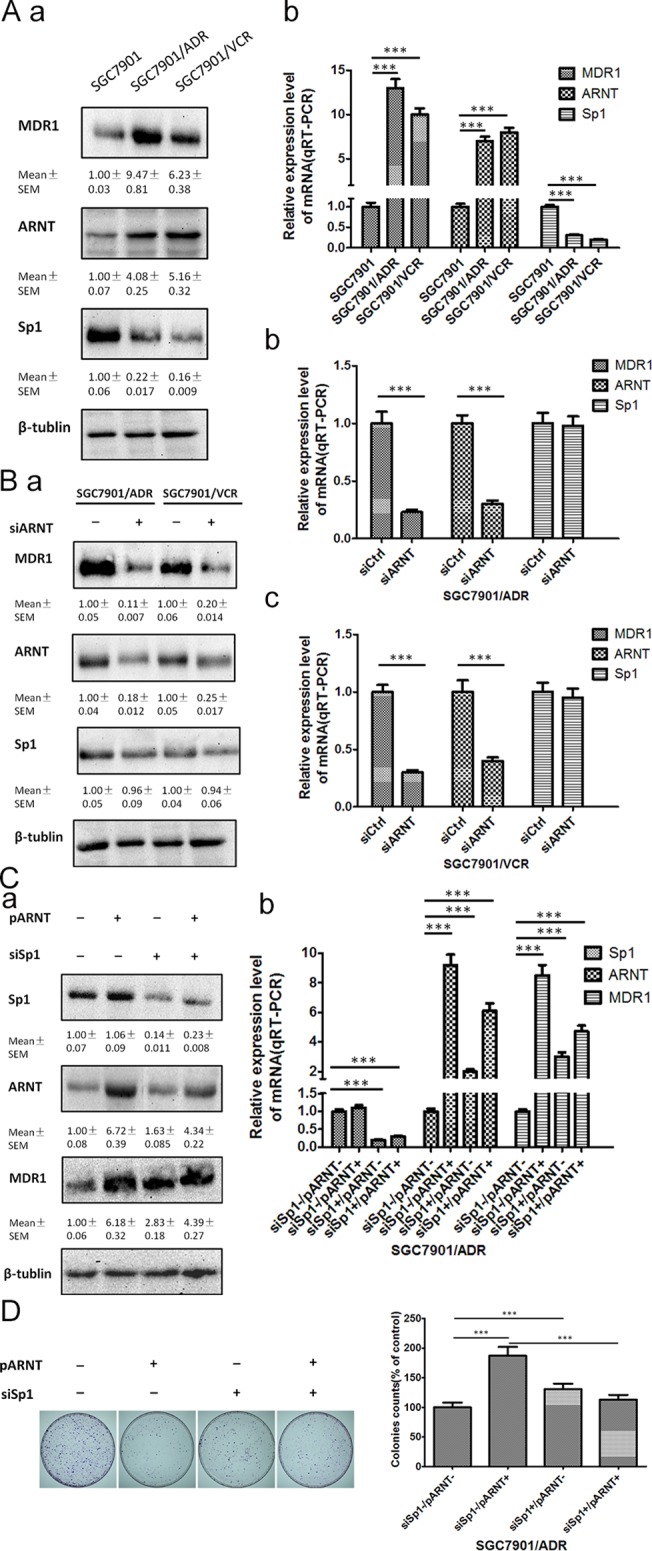
ARNT–MDR1 pathway mediated the drug-resistance phenotype gastric cancer.(A) expression of ARNT, MDR1 and Sp1, a, western blotting, b, qRT-PCR. (B) The effect of siARNT transfection on the expression of ARNT, MDR1 and Sp1, a, western blotting, b, qRT-PCR of SGC7901/ADR, c, qRT-PCR of SGC7901/VCR. (C) The effect of pARNT (ARNT expression vector) and siSp1 transfection on the expression of ARNT, MDR1 and Sp1, a, western blotting, b, qRT-PCR of SGC7901/ADR. (D) Plate colony formation assay of SGC7901/ADR cells with the adriamycin supplement into the culture media (1μg/ml) at the designated time. (Data were means of three separate experiments (mean ± SEM), one-way ANOVA analysis, *** p < 0.0001).